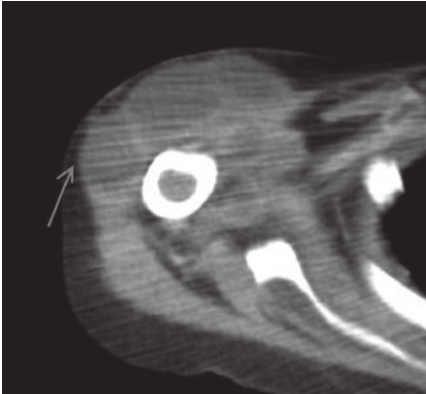
Figure 2: Loculated fluid collections surrounding the proximal portion of the right